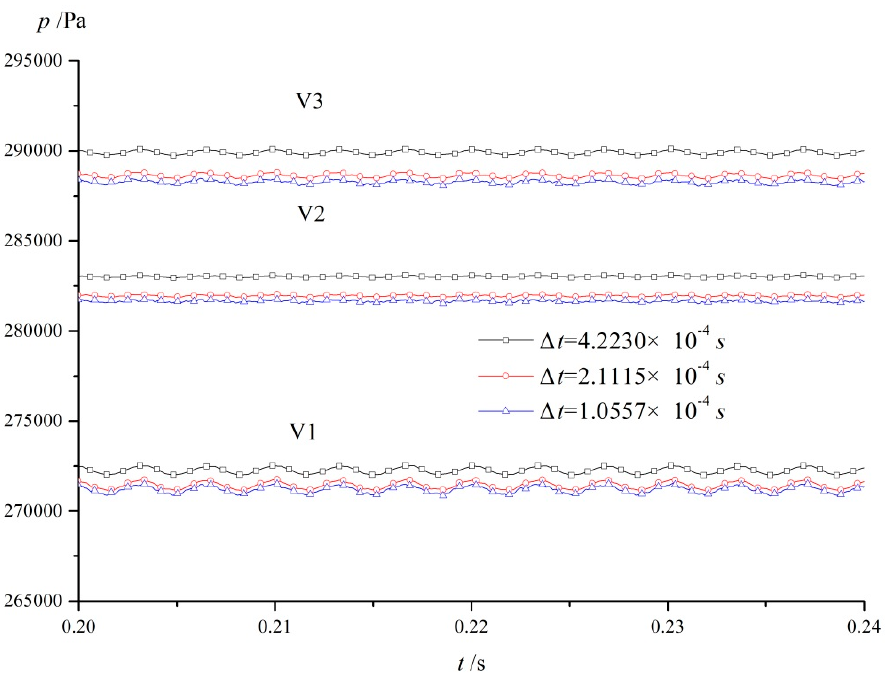
Figure 4. Time histories of pressure fluctuations on V1, V2 and V3 using different time steps.